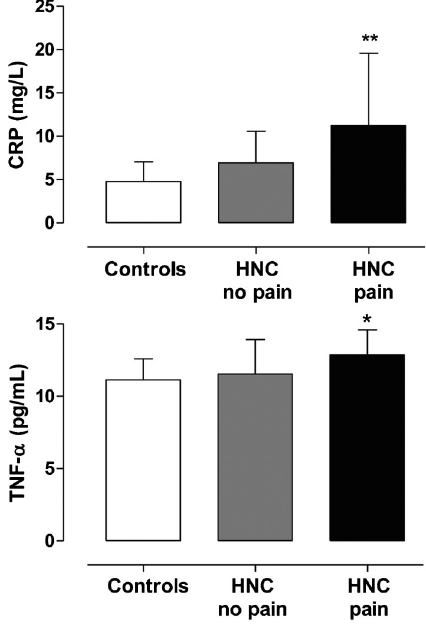
Figure 1. Serum C-reactive protein (CRP) and tumor necrosis factor-alpha (TNF- a ) levels in head and neck cancer (HNC) patients with pain, no pain, and controls. *P , 0.05, **P , 0.01 compared with HNC no pain and controls (one-way ANOVA and the Fisher test).